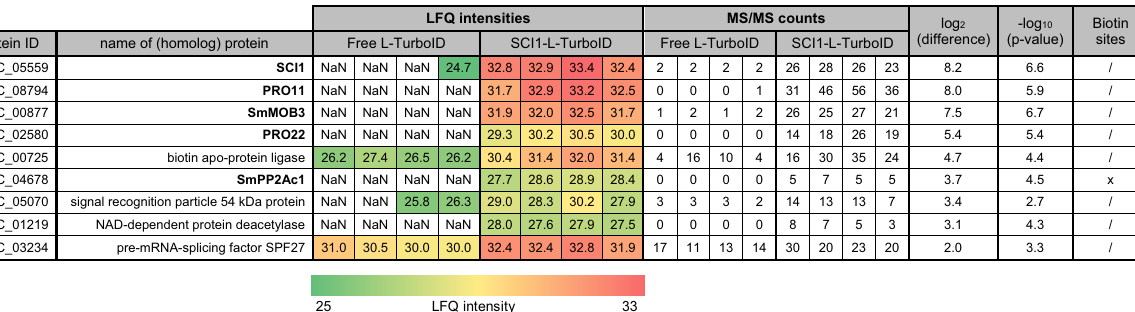
Table 2. Significantly enriched proteins co-localizing with SCI1-L-TurboID in BioID. This BioID experiment was performed with the S. macrospora strains Δsci1::p5’-sci1-L-TurboID ect (SCI1-L-TurboID) and wt::pc- L-TurboID ect (free L-TurboID, control). Four biological replicates each were grown in liquid SWG (50 nM biotin) for 4 days at 27 °C under continuous light conditions. Significant proteins (enrichment factor ≥ 4) were selected from a volcano plot (two-sample Student’s T-test; FDR = 0.01; s0 = 2) after filtering for 50% valid values in total. Missing values were imputed in 4 replicates. log 2 (difference) and -log 10 (p-values) are means of these 4 imputations. Proteins are sorted in descending order based on the log 2 (difference) values. LFQ intensities are color-coded: high values are shaded in red and low intensities are shaded green. Bold proteins indicate known components of the SmSTRIPAK complex. Protein names were identified through the UniProtKB BLAST (for identity % and e-values see Supplementary Table S5). [Sm], Sordaria macrospora; [Nc], Neurospora crassa ; [Nt], Neurospora tetrasperma ; [Mm], Madurella